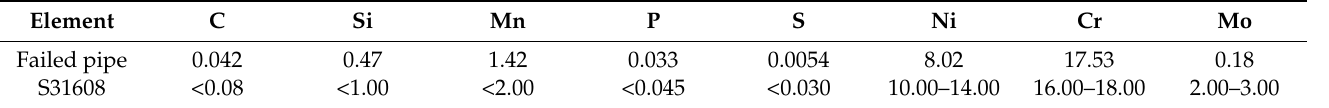
Table 1. The chemical composition (wt.%) of the failed tube and standard S31608.